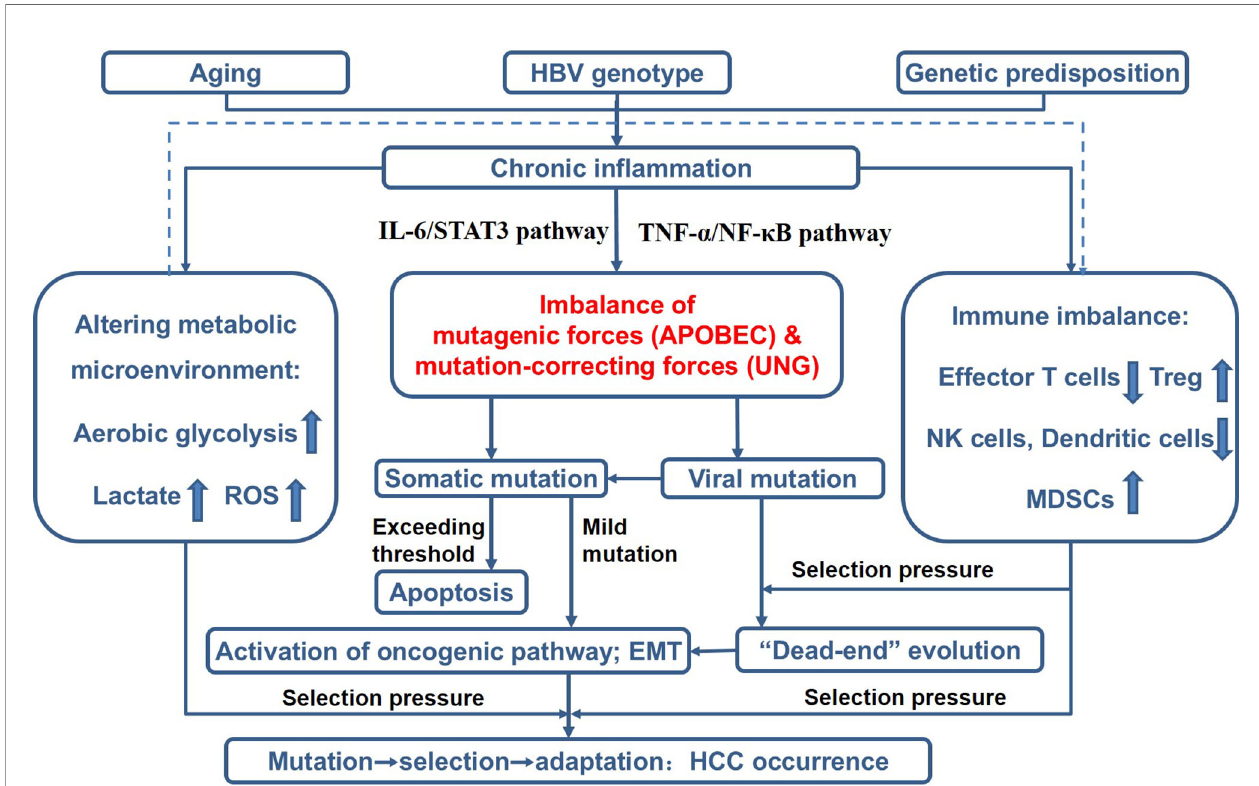
FIGURE 1 | Theoretical framework of Cancer Evo-Dev , as exampled by HBV-induced hepatocarcinogenesis. ROS, reactive oxygen species; Treg, regulatory T cells; NK cells, natural killer cells; MDSCs, myeloid-derived suppressor cells; EMT, epithelial-mesenchymal